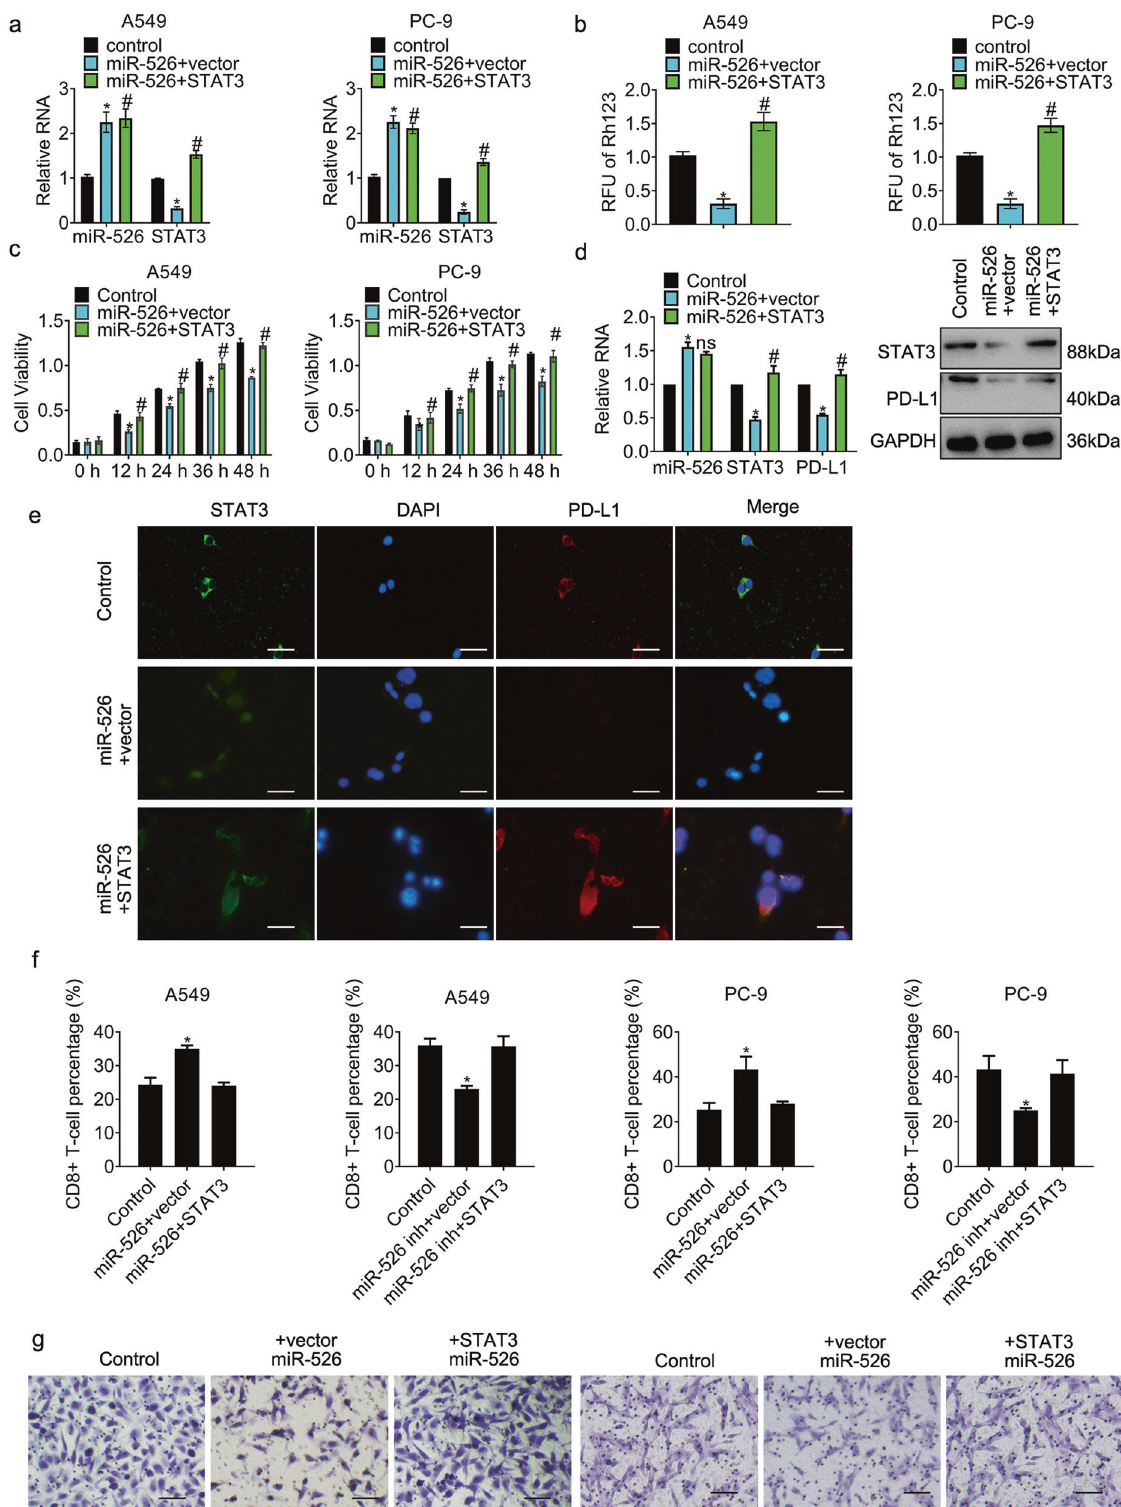
Fig. 4 STAT3 overexpression overwhelms the inhibition of miR-526b-3p in cancer cells. a miR-526b-3p and STAT3 expression is accessed by qRT-PCR. b The activity of MDR1 is measured by rhodamine123 ef fl ux assay. RLU relative fl uorescence of unit. c The viability of the indicated cells is accessed by MTT assay. d The expression of the indicated genes is detected by qRT-PCR and Western blot, separately. e Representative immuno fl uorescent images of STAT3 and PD-L1 in A549 cells are shown. f The percentage of CD8 positive T-cells in the indicated cells are accessed by fl ow cytometry analysis. g The motility of the indicated cells was detected by transwell migration assay. Scale bar, 100 µm. *, P < 0.05 vs control. #, P < 0.05 vs miR-526b-3p plus vector.